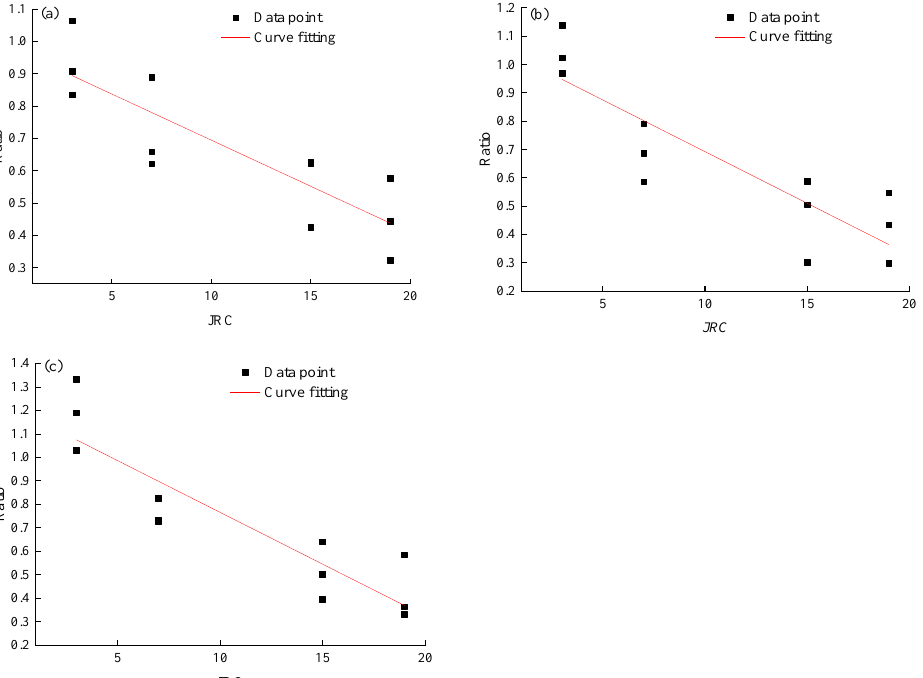
Figure 14: The relationship between experimental value and calculation value with different filling joints: (a) semi-solid soil; (b) plastic soil; and (c) soil liquid.